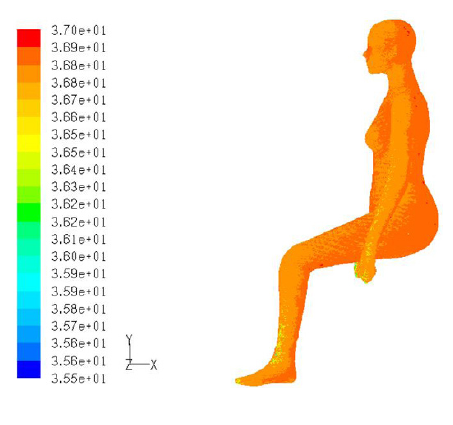
Figure 11. Body core temperature [ ◦ C].